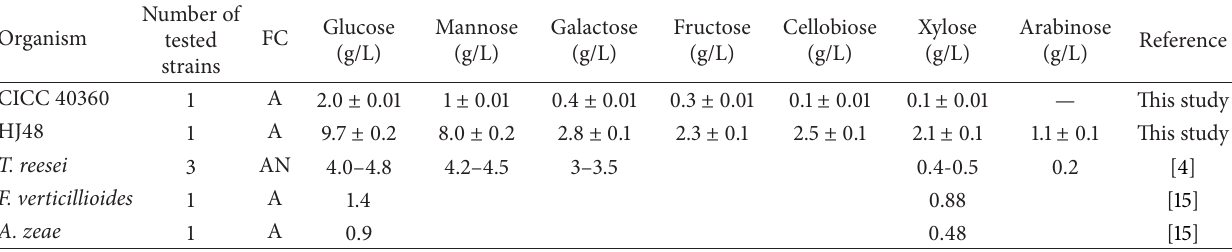
Table 3: Fungus producing ethanol from biomass directly.